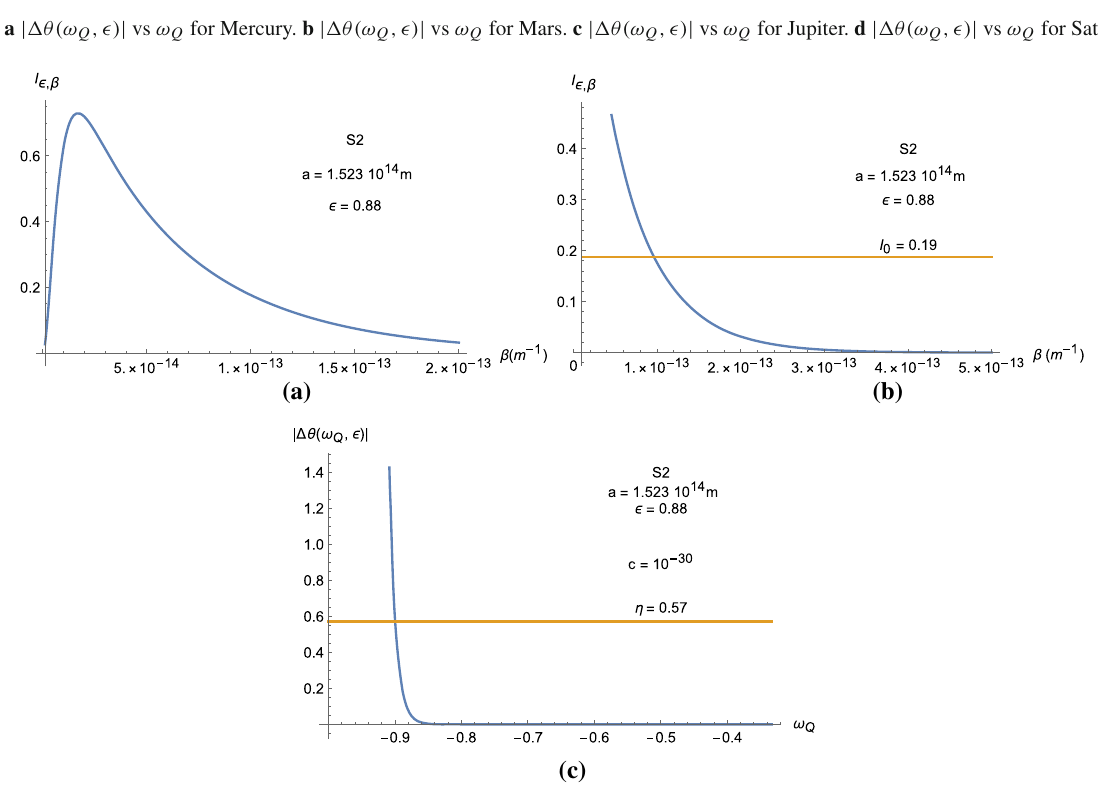
Fig. 5 a I (cid:10),β vs β for S2 star in FOG theories. b I (cid:10),β vs β for S2 star. c | (cid:7)θω Q ,(cid:10) | vs ω Q for S2 star. ( c is in m 3 ω Q + 1